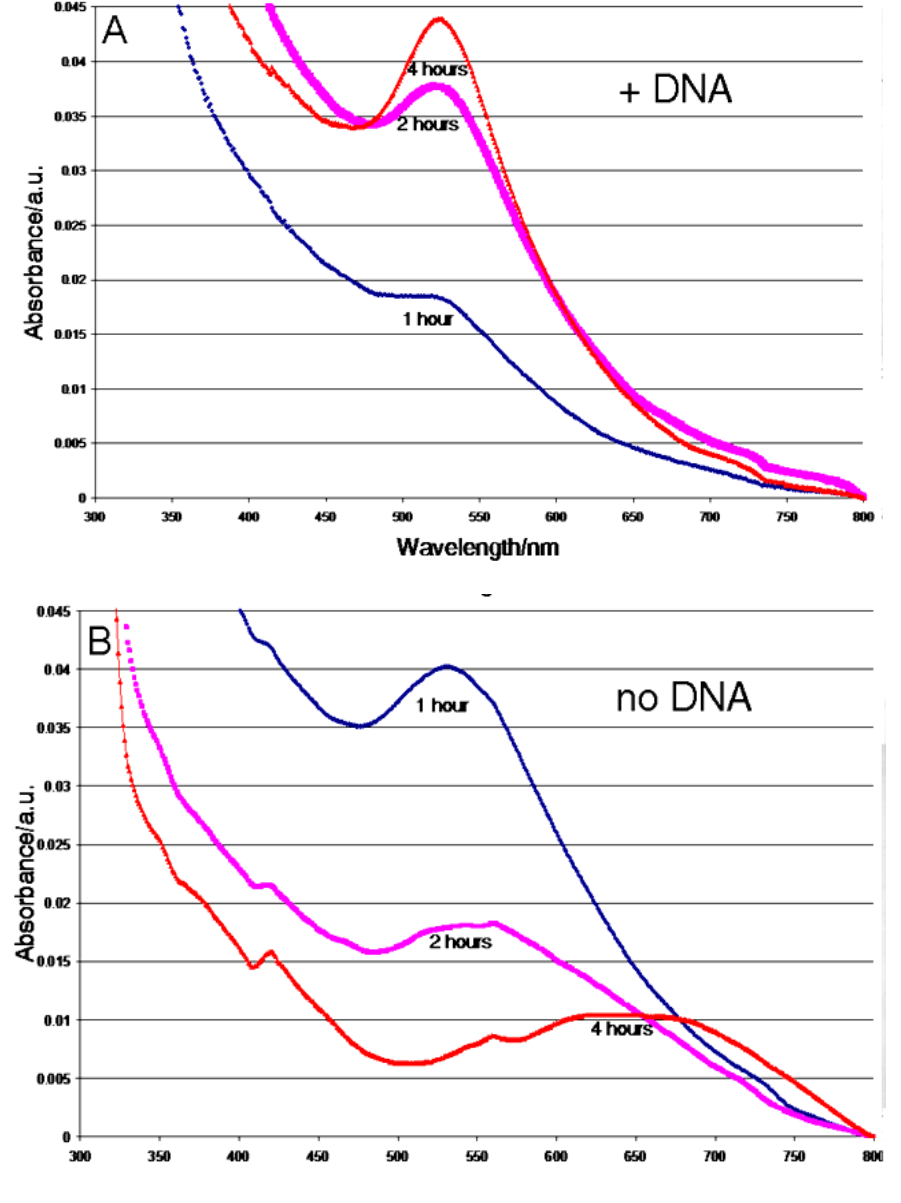
Figure 2. ( A ) The UV-visible spectra of the Au nanoparticles formed by heating the solution containing the DNA in TE buffer and the gold phosphine at 70 °C in the dark for 1 h (blue line), 2 h (pink line), and 4 h (red line). Transmission electron microscopy images were taken of these three samples. ( A1 ) TEM image of the sample heated for 1 h, ( A2 ) TEM image of the sample heated for 2 h, and ( A3 ) TEM image of the sample heated for 4 h. ( B ) The UV-visible spectra of the Au nanoparticles formed in control reactions by heating the solution containing only the gold phosphine and the TE buffer at 70 °C in the dark for 1 h (blue line), 2 h (pink line), and 4 h (red line). Transmission electron microscopy images were taken of these three control samples. ( B1 ) TEM image of the control sample heated for 1 h, ( B2 ) TEM image of the control sample heated for 2 h, and ( B3 ) TEM image of the control sample heated for 4